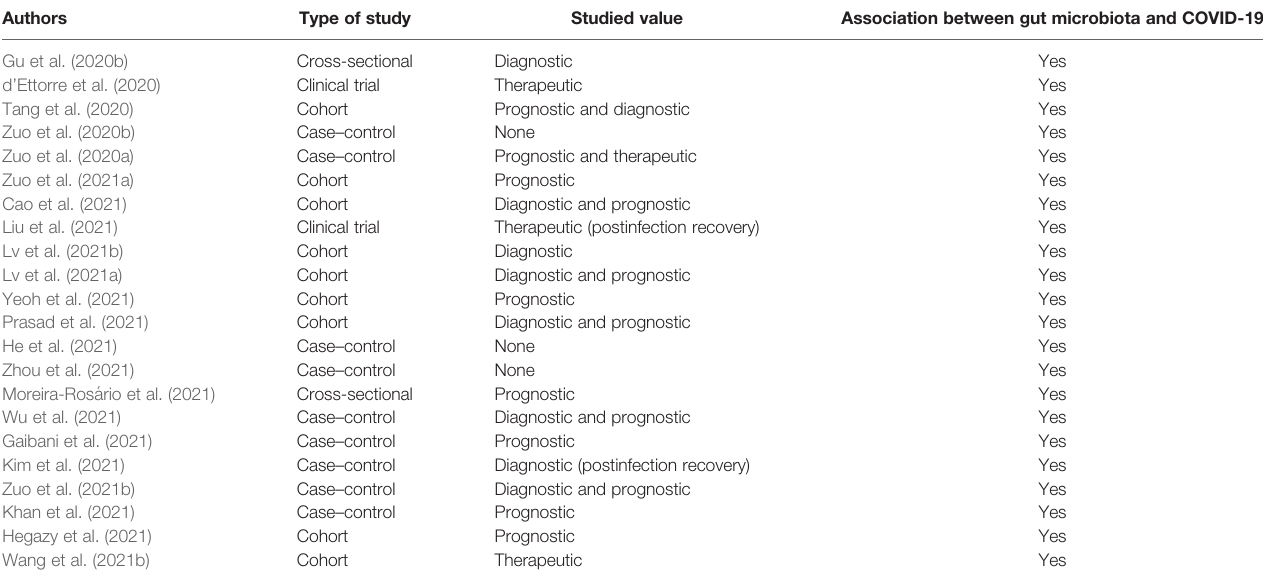
TABLE 3 | Association between gut microbiota and